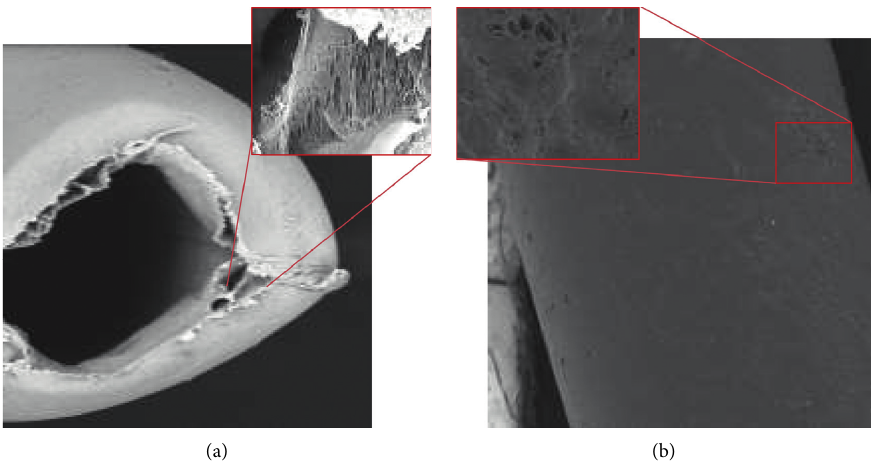
Figure 2: SEM micrograph of (a) cross section and (b) top surface of PVDF hollow fiber membrane.